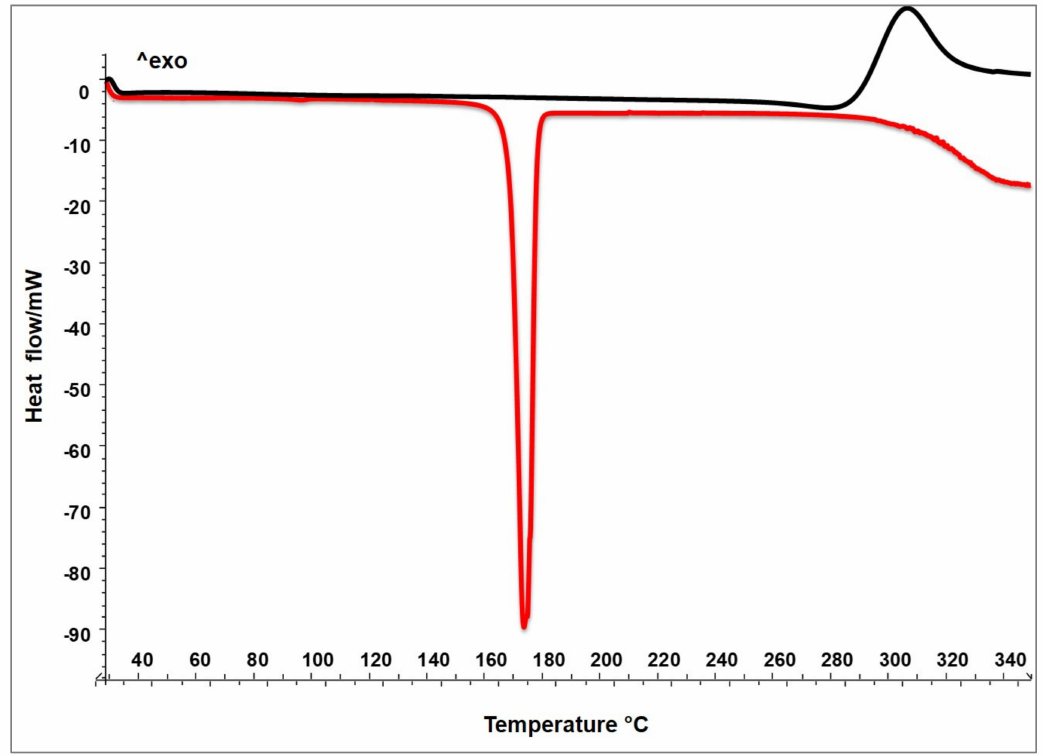
Figure 1. DSC of raw materials: chitosan (C black line) and mannitol (M red